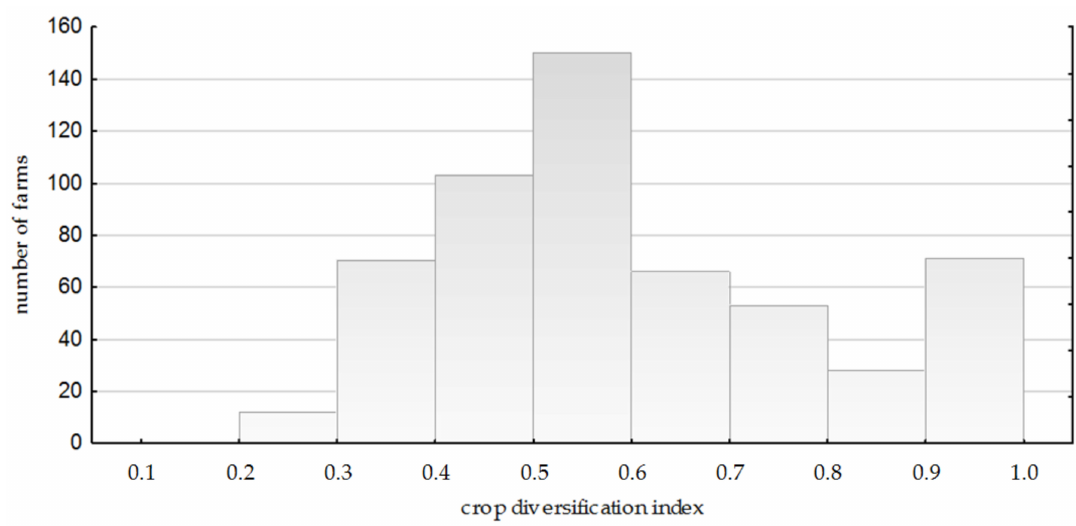
Figure 1. Distribution of the crop diversification index. Source: the authors’ own analysis based on FADN data.